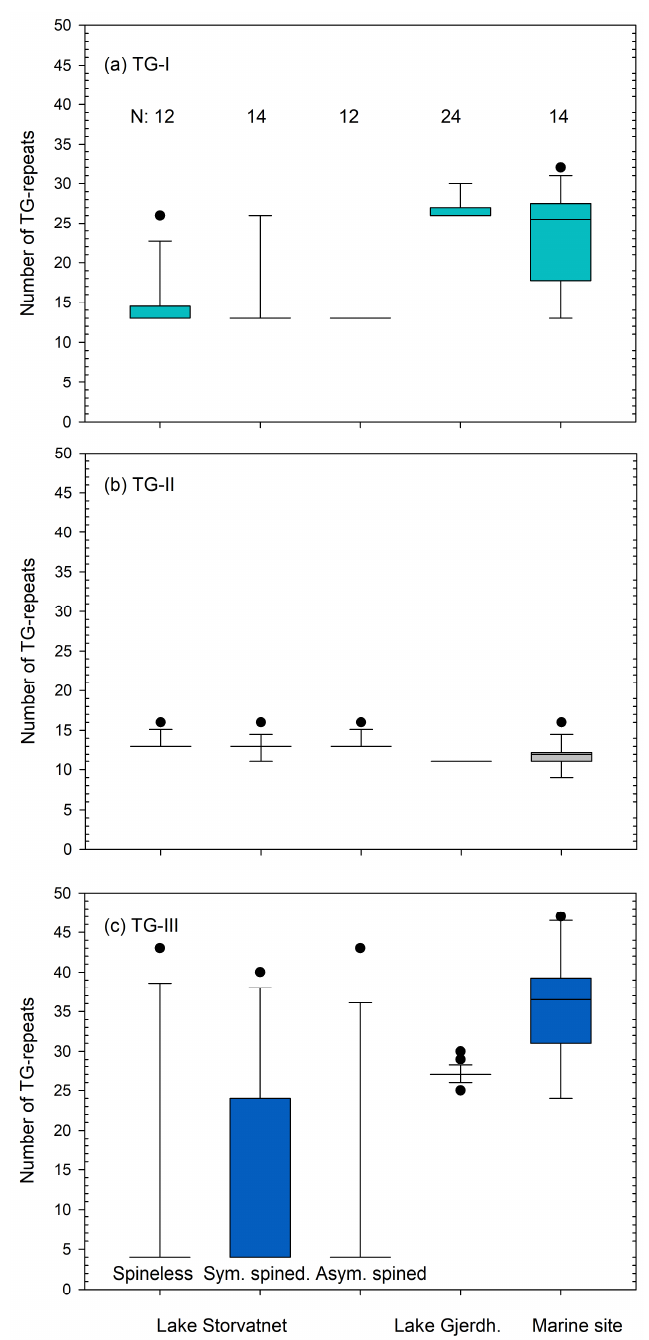
Figure 4. Box–whisker plots showing the number of repeats of ( a ) TG-I, ( b ) TG-II, and ( c ) TG-III, for spineless, symmetric, and asymmetric specimens from Lake Storvatnet, and spined specimens from Lake Gjerdhaugvatnet and the marine site. See also Supplementary Figures S2 and S3. Numbers (“N”) in the figure show the number of alleles examined.